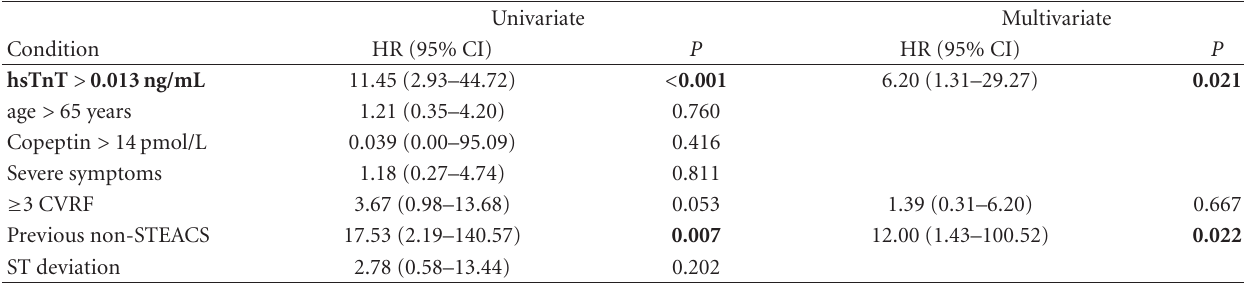
Table 5: Cox regression analysis at 12-month followup for patients without invasive catheterization ( n =